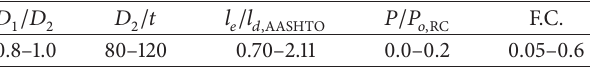
Table 2: Ranges of the values of each study parameter. 𝐷 /𝐷 1